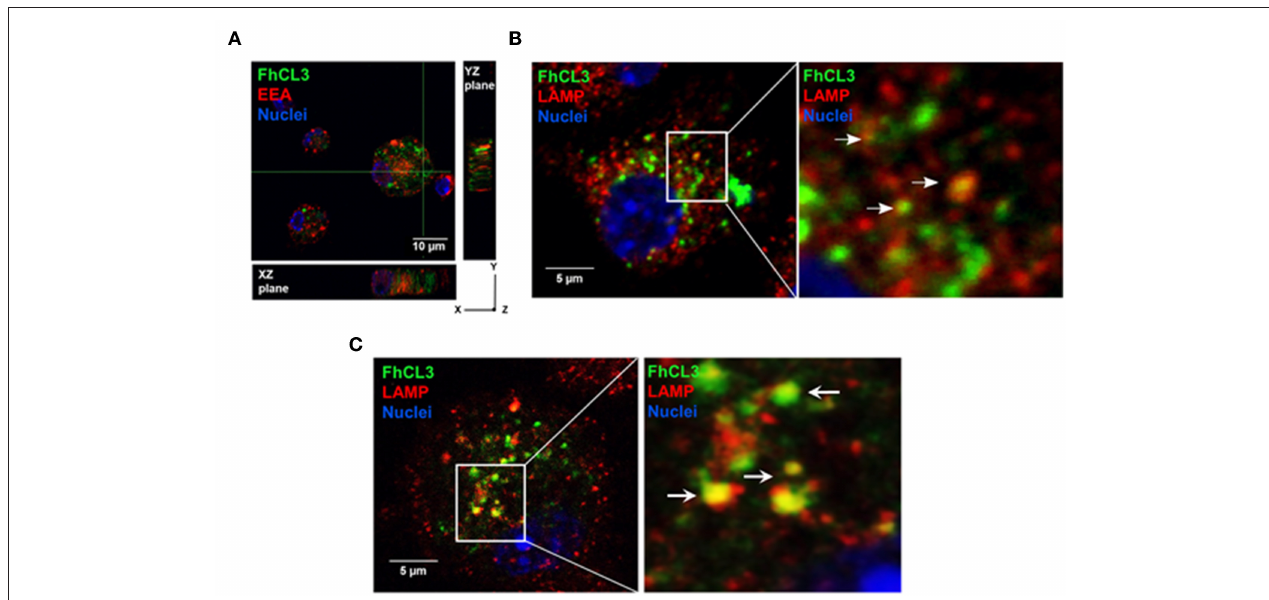
FIGURE 2 | Intracellular location of FhCL3, analyzed by Confocal Laser Scanning Microscope. DCs were incubated for 30min, 4h or 18h with Alexa Fluor ® 488-labeled FhCL3 (green) to evaluate co-localization with early endosomes and lysosomes, respectively. (A) Cells were stained with EEA-1, early endosomal antigen 1, in red. Orthogonal projections of z-stacks are depicted. The cell nucleus was used as an internal reference point. The XZ and YZ planes show the cell height and width, and height and length, respectively. (B,C) LAMP, in lysosomes are showed red at 4h and after 18h, respectively. Cell Nuclei were stained with Hoechst. Higher magnifications of selected areas are shown on the right. These images are representative at least two experiments. The scale bar is 10 micron in (A) and 5 micron in (B,C) .